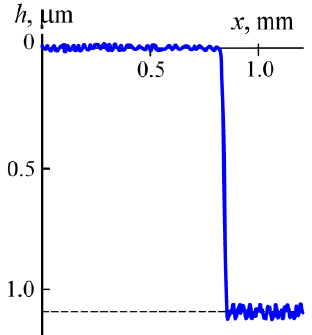
Figure 5. Profilogram of a plate surface covered with a mask and bombarded with fast argon atoms.